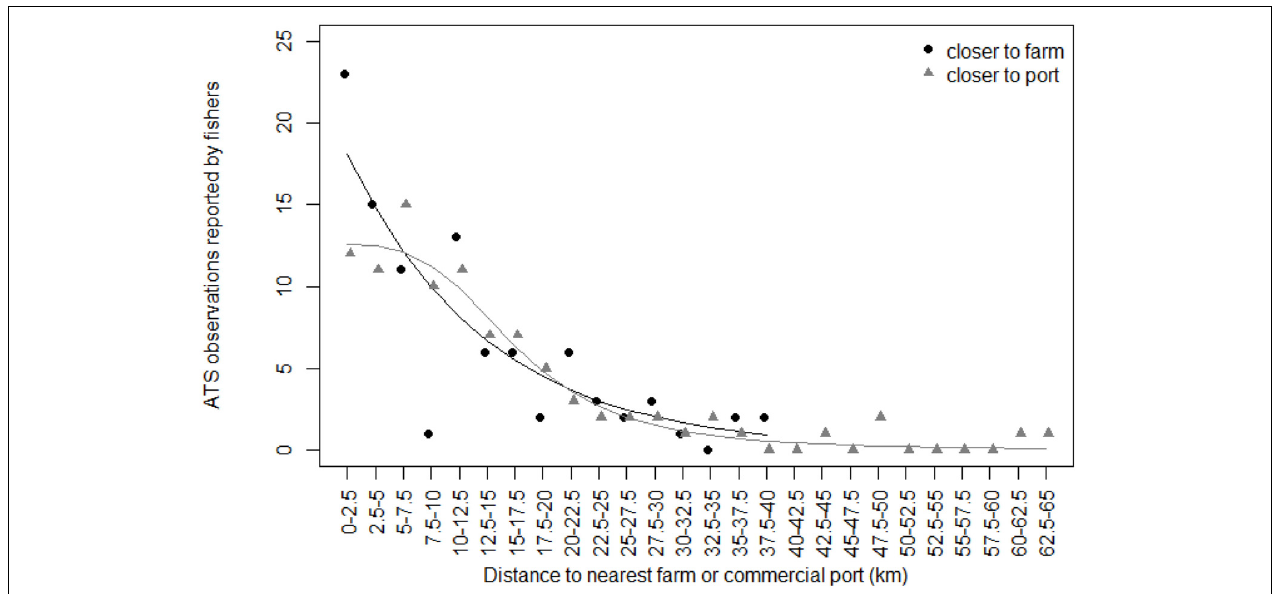
FIGURE 4 | Relationship between Abnormally Tough Specimen (ATS) observations reported by fishers and distance to the nearest farm (black dots) or commercial port (gray triangles). ATS observations are grouped according to distance classes of 2.5 km. The black line is prediction from glm on farm data. The gray line is prediction from exponential nls on port